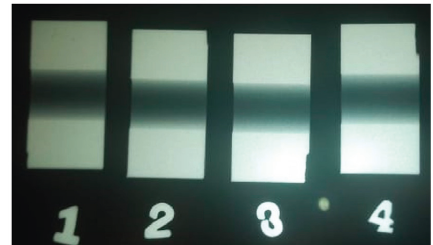
Figure 5: X-ray radiography of the printed